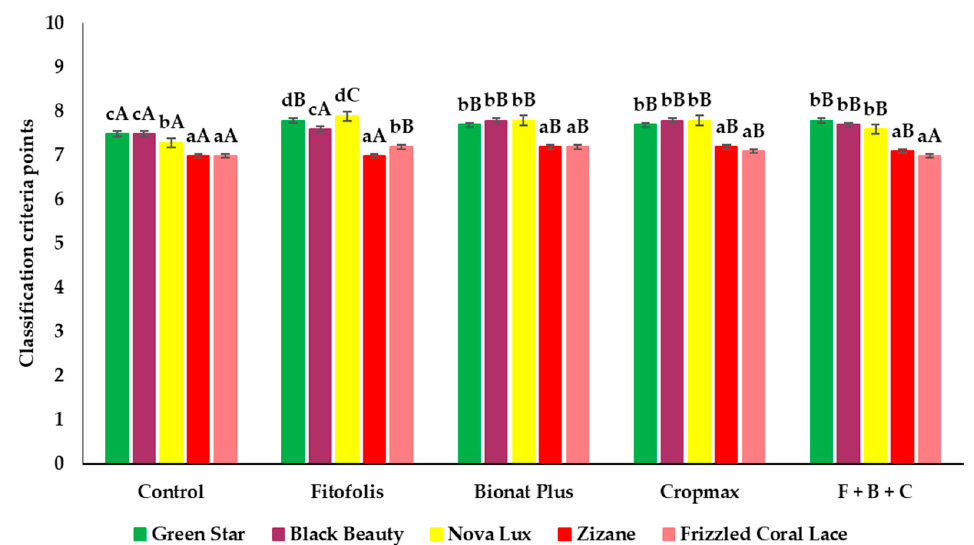
Figure 3. Effect of foliar fertilization on vase durability of Gladiolus varieties: ‘Green Star’, ‘Black Beauty’, ‘Nova Lux’, ‘Zizane’, and ‘Frizzled Coral Lace’. Vase durability of floral stems produced under control conditions and in the presence of the indicated foliar fertilization: Fitofolis, Bionat Plus, Cropmax and the mixture of Fitofolis–Bionat Plus–Cropmax (F + B + C). Bars represent the means ± SE ( n = 5). Different lowercase letters above the bars indicate significant differences between the five varieties for each foliar fertilization, and different uppercase letters indicate significant differences between treatments, according to Tukey test ( α = 0.05).